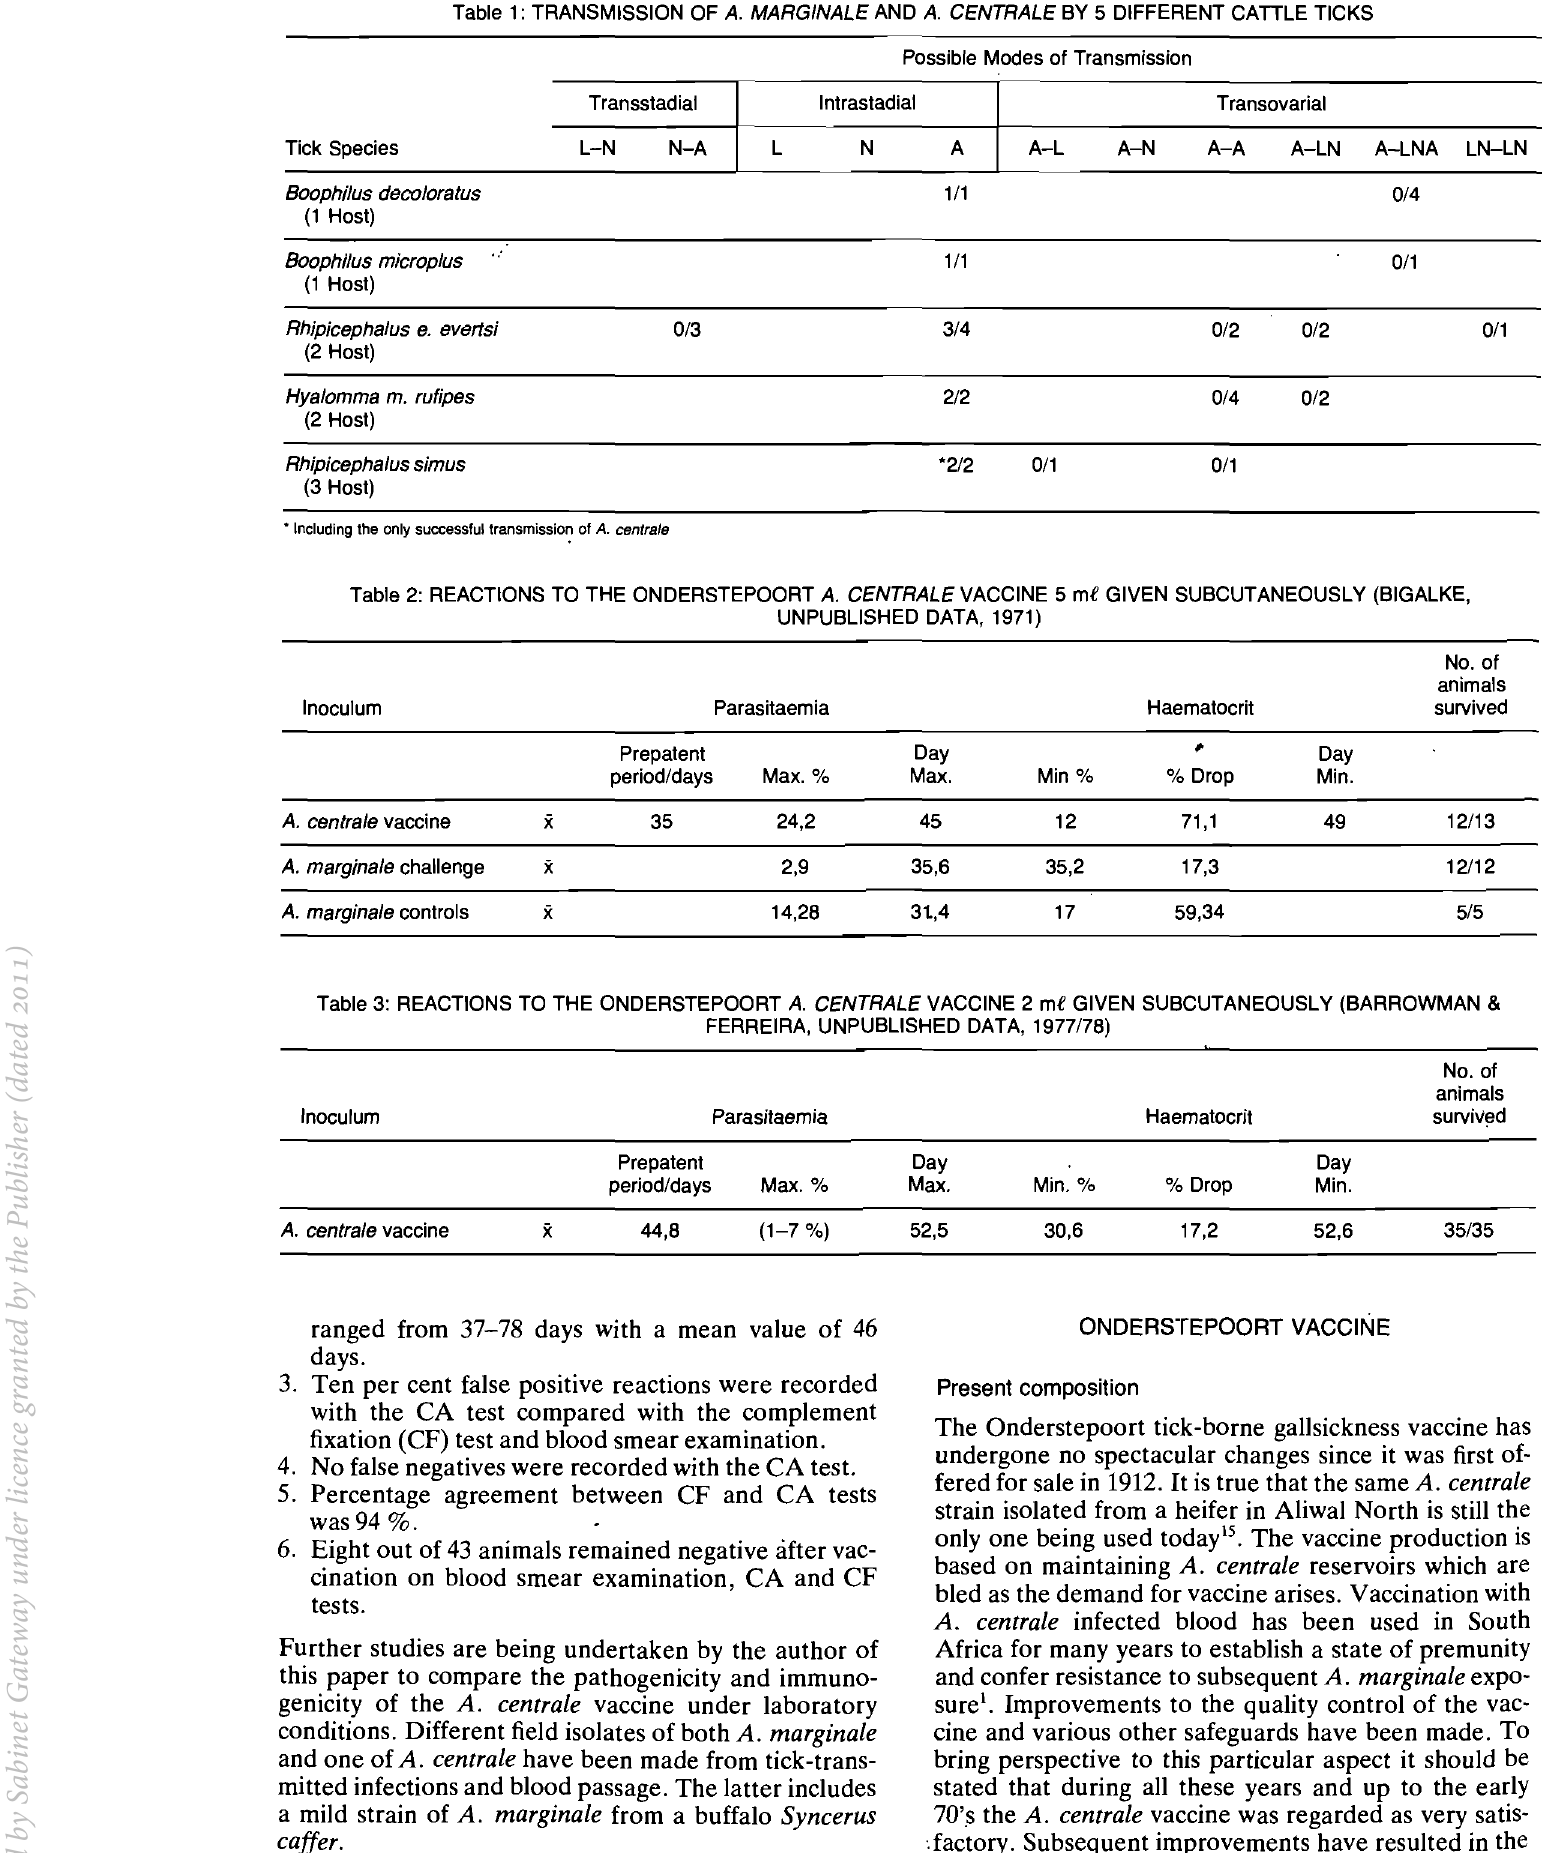
Table 1: TRANSMISSION OF A. MARGINALE AND A. CENTRALE BY 5 DIFFERENT CATTLE TICKS Possible Modes of Transmission